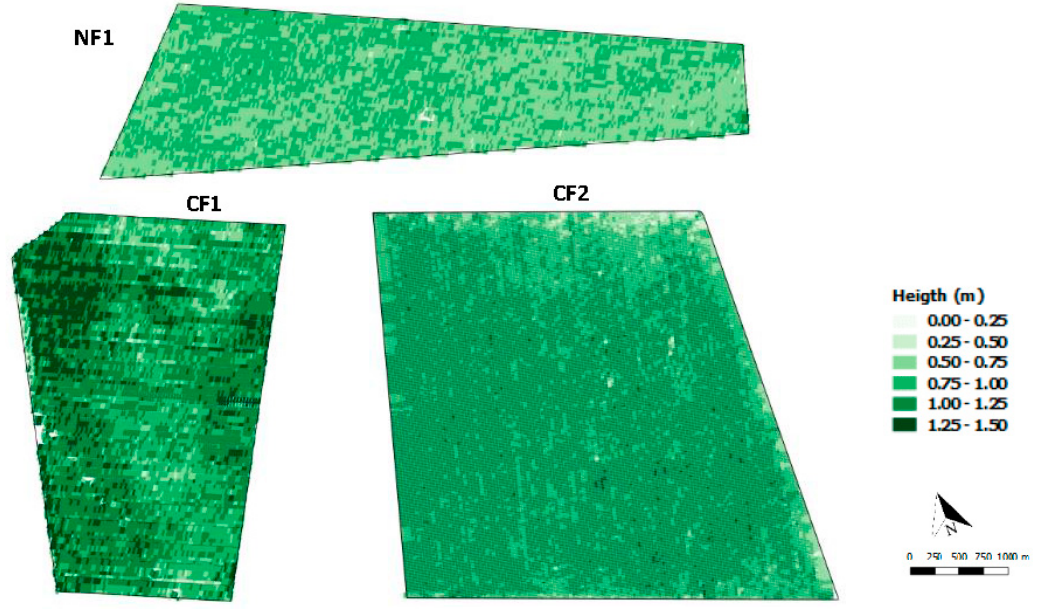
Figure A4. Spatial distribution of crop height measured by ultrasonic sensors before harvest of cotton cultivated in two systems: narrow row (NF1) and conventional row spacing (CF1 and CF2).